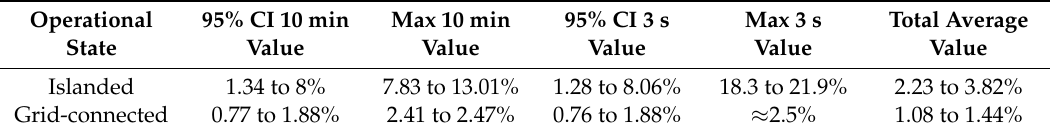
Table 1. 95% Confidence interval (CI) for the 10 min values, the maximum 10 min value and total average value for all three phases in islanded and grid-connected